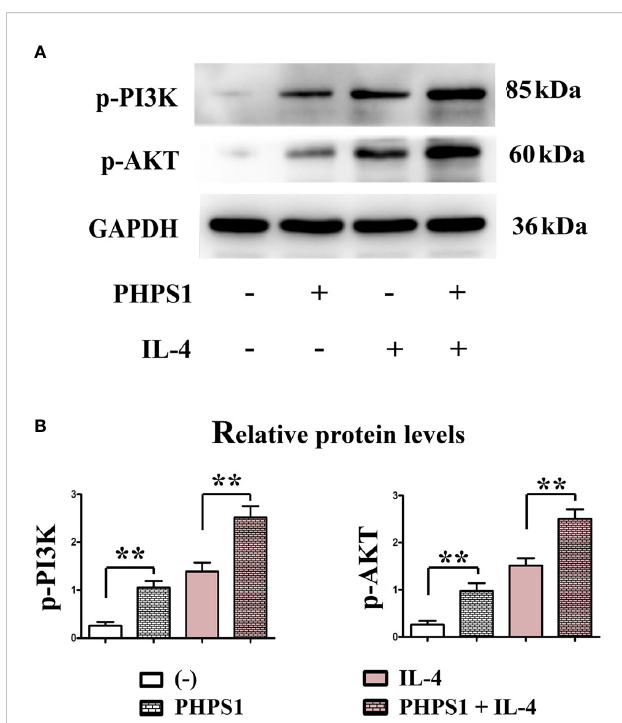
FIGURE 7 Low SHP-2 expression activated PI3K signaling pathway in M2 macrophages (A, B) . The protein expressions of p-PI3K and p-AKT in macrophages. All experiments were independently repeated three